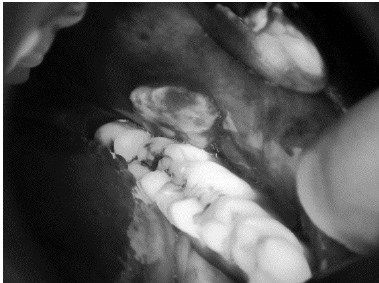
Figure 16. Grayscale VELscope ® image of the oral mucosal cavity.